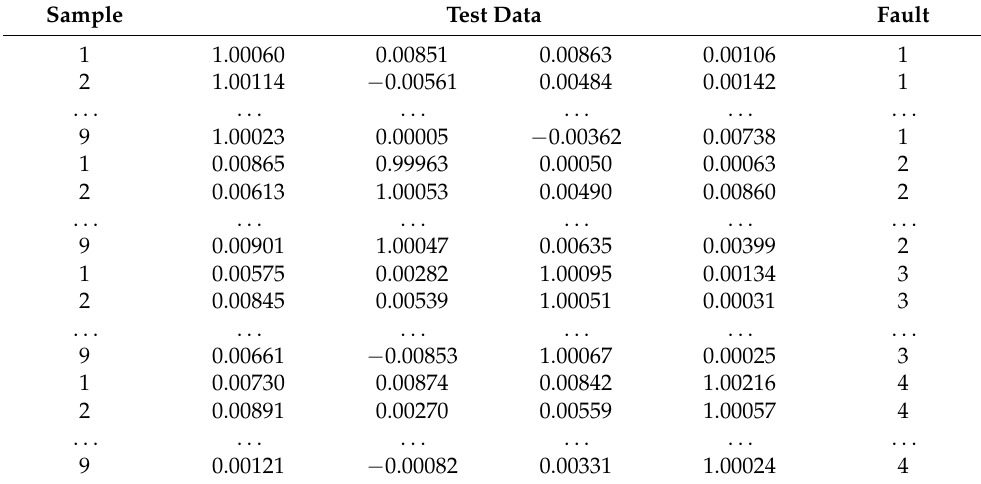
Table 3. GA-BP algorithm test data.